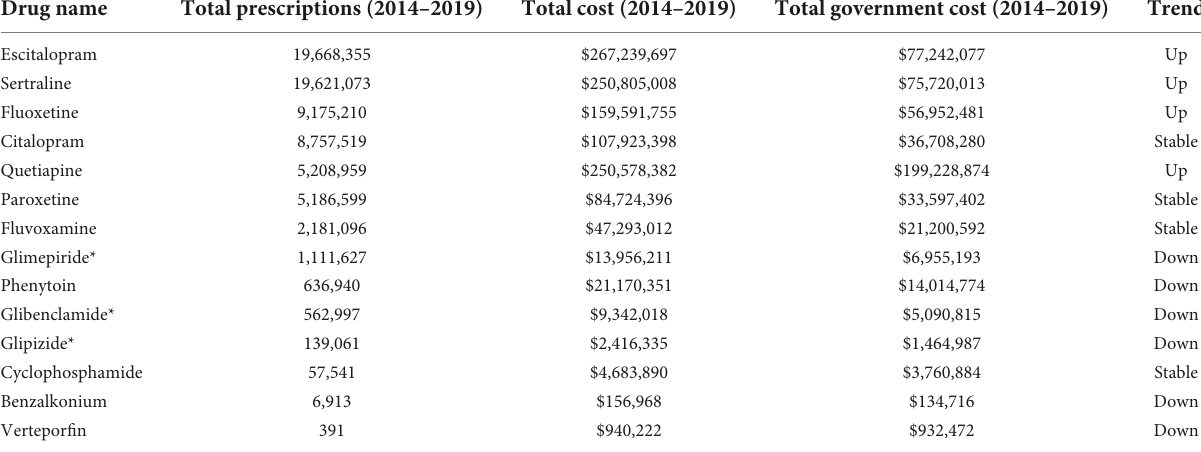
TABLE 3 PBS data (2014–2019) showing prescription and cost data for drugs that have a probable association with cataract; drugs with gray background are psychotropic drugs (gray background = psychotropic